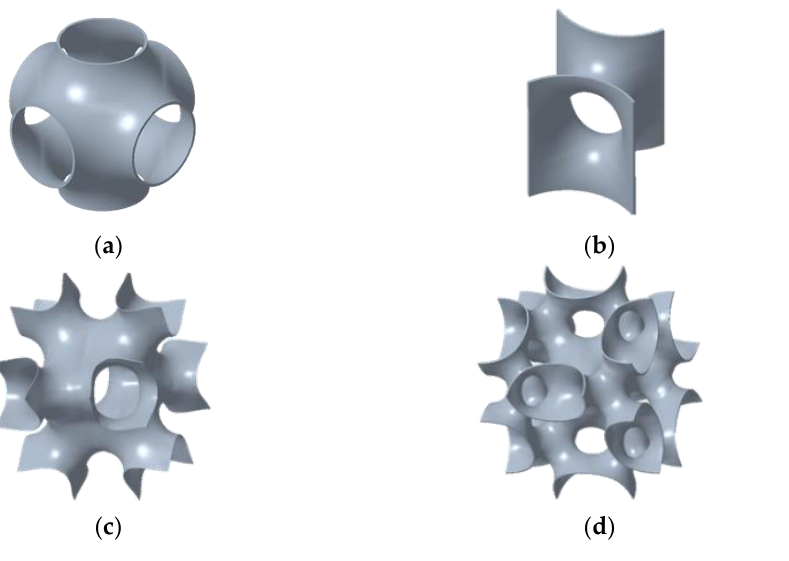
Figure 1. Cell geometries of different TPMSs: ( a ) SP, ( b ) S2, ( c ) I-WP and ( d ) F-RD.